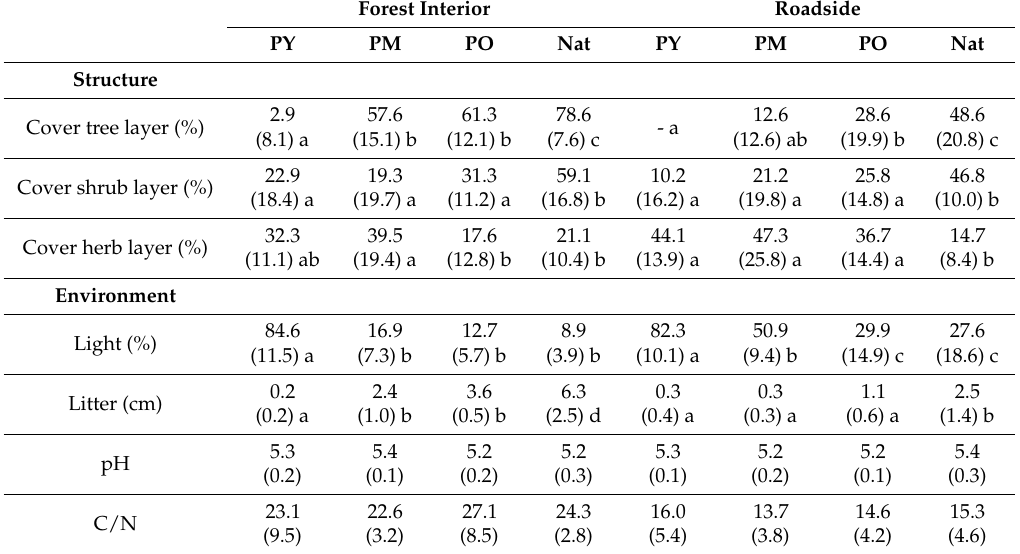
Table 1. Vegetation structure and environmental characteristics of the different plantation age classes in comparison to the natural forest. Given are transect-based mean values (with standard deviation in parenthesis) of vegetation layer cover and measured environmental variables. Different letters indicate significant differences among age classes and the natural forest respectively based on linear mixed model results.